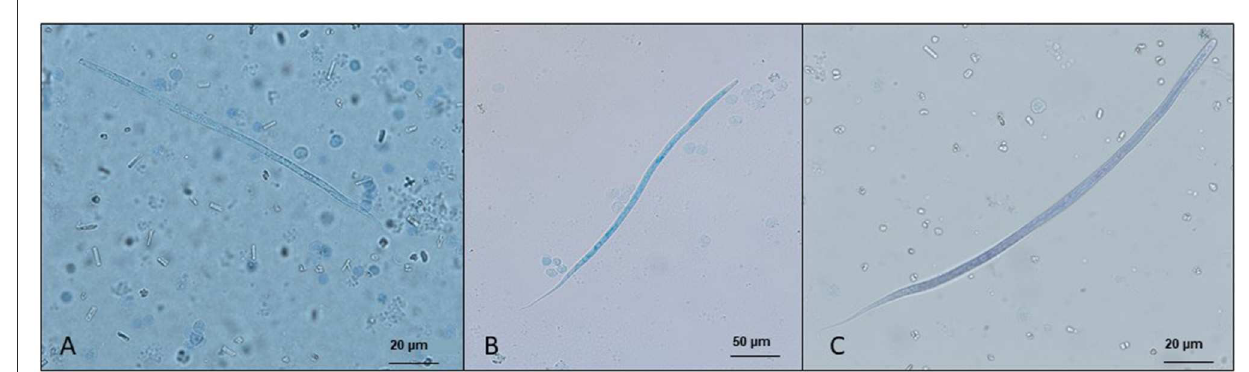
FIGURE3 Microfilariae detected in blood samples by a modified Knott’s test and stained with methylene blue. (A) Acanthocheilonema reconditum ; scale bar: 20 µ m. (B) Dirofilaria immitis ; scale bar: 50 µ m. (C) Dirofilaria repens ; scale bar 20 µ